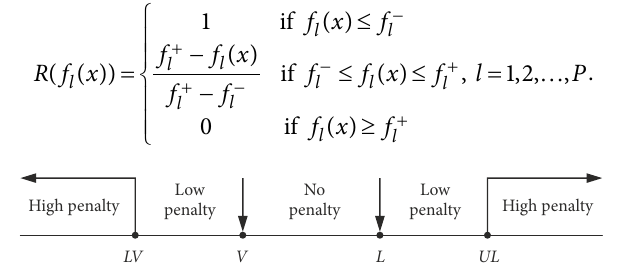
Figure 1. Soft time-window with non-on-time delivery